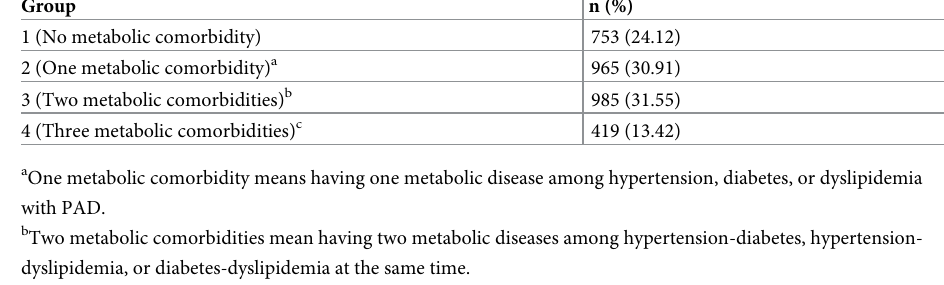
Table 2. Number of participants by the total number of metabolic comorbidities with PAD (n = 3,122). Group n (%)